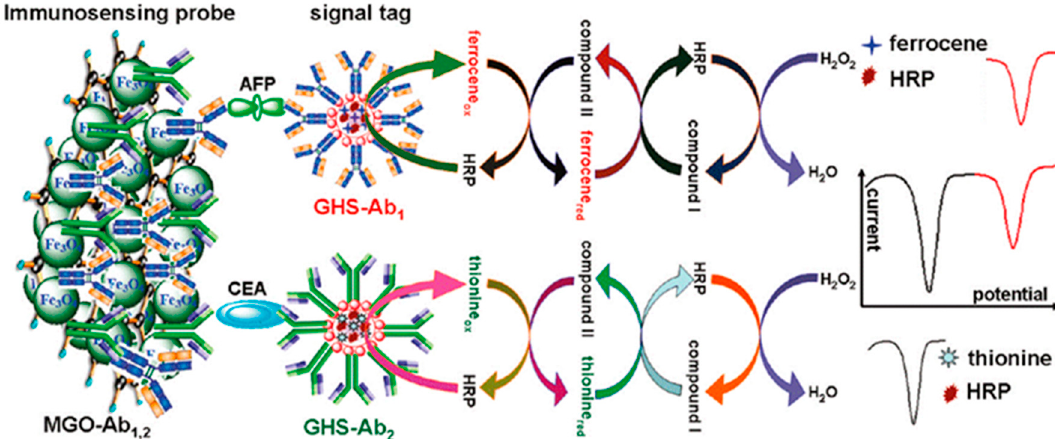
Figure 12. Scheme of the multiplexed electrochemical immunoassay for CEA and AFP using magnetic graphene nanosheets with immobilized capture antibodies as immunosensing probes, and multifunctional nanogold hollow microspheres (GHS) with encapsulated HRP-THI and HRP-Fc as distinguishable signal tags. Figure shows also some of the voltammograms recorded. Reprinted from Ref. [17] with permission.